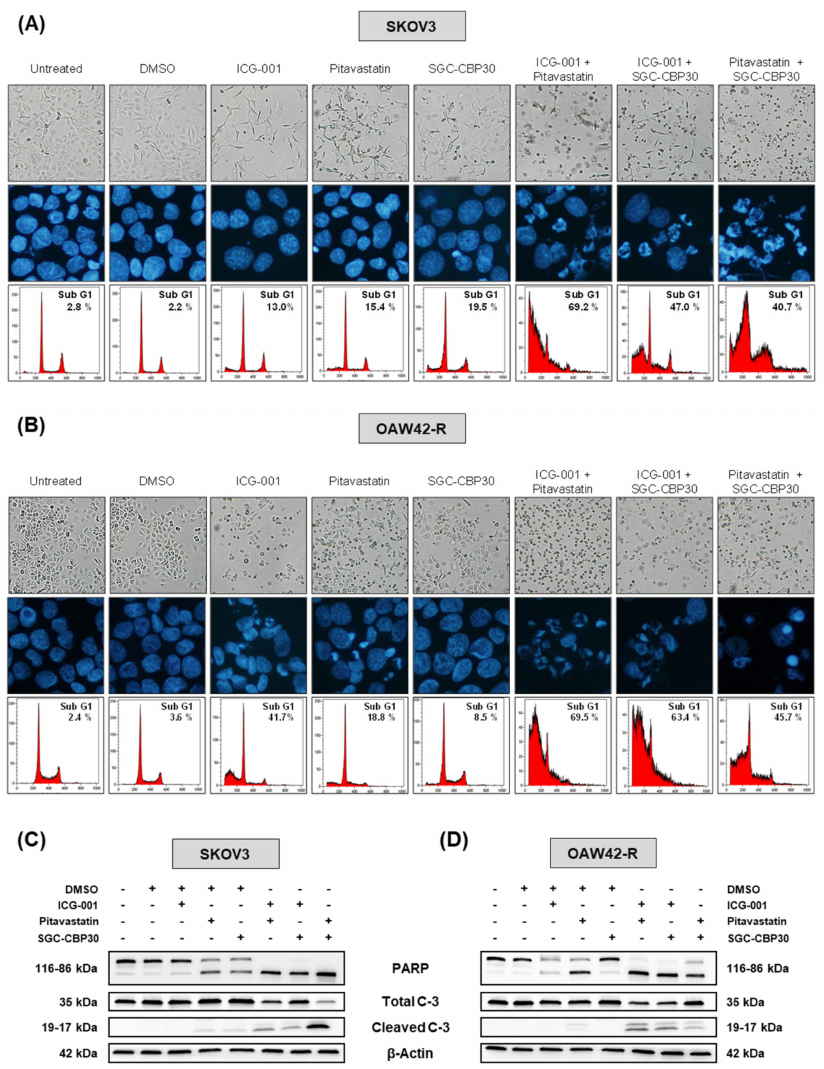
Figure 6. Combined inhibition of selected hubs cooperates to induce cell death in SKOV3 and OAW42-R chemoresistant ovarian cancer cells. ( A , B ) Representative pictures of the cell layer (scale bar = 50 µ m, magnification: 20 X) and DAPI nuclei staining 48 h after the indicated treatments of SKOV3 cells ( A ) or OAW42-R cells ( B ). Condensed and fragmented DAPI-stained nuclei are typical of apoptosis. Flow cytometry results show cell distribution into the cell cycle 48 h after treatments; sub-G1 events represent fragmented nuclei and cell death. ( C , D ) Western blot analysis of PARP and caspase-3 and the respective cleaved fractions on cell extracts harvested 48 h after treatments in SKOV3 cells ( C ) or OAW42-R cells ( D ). β -actin was used as a loading control. Results are representative of at least three independent